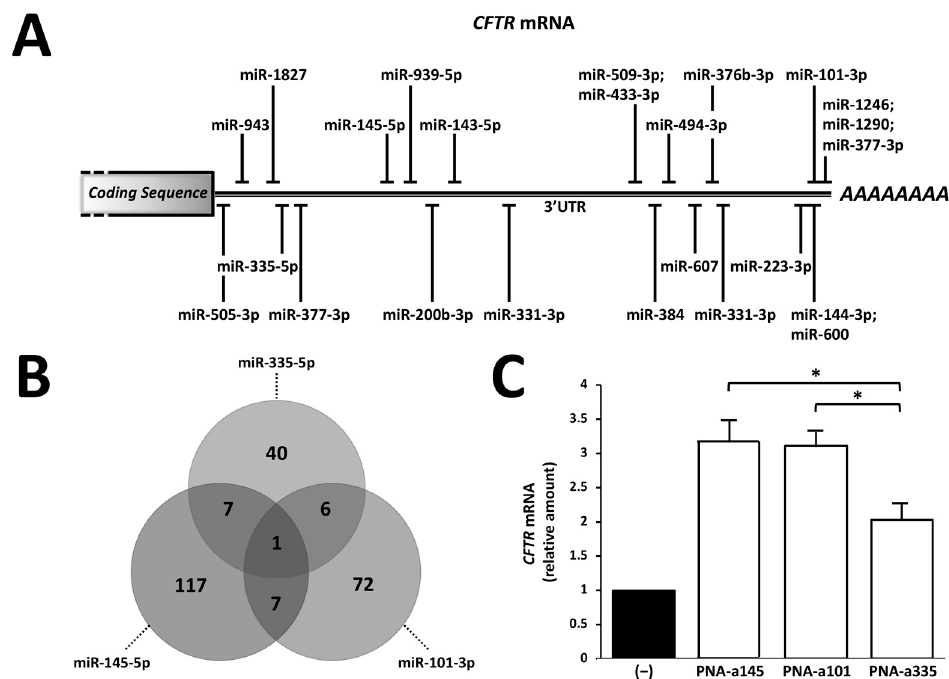
Figure 1. Characterization of the biological activity of miR-145-5p, miR-101-3p, and miR-335-5p on CFTR gene expression. ( A ) microRNA binding sites present within the 3 ′ UTR of CFTR mRNA; ( B ) Venn-diagram indicating the number of mRNA targets of miR-145-5p, miR-101-3p, and miR-335-5p: only CFTR mRNA is a molecular target of all the three microRNAs. Analysis of mRNAs targeted by miRNAs was conducted using TargetScan (release 8.0) and data already in the literature. Afterwards, a Venn-diagram was performed using a Draw Venn Diagram tool (http://bioinformatics.psb.ugent.be/webtools/Venn/, accessed on 9 May 2022); ( C ) upregulation of CFTR mRNA following treatment of Calu-3 cells with PNAs against miR-145-5p (PNA-a145), miR-101-3p (PNA-a101) and miR-335-5p (PNA-a335). n = 3 independent RT-qPCR experiments (* indicates differences with p < 0.05).